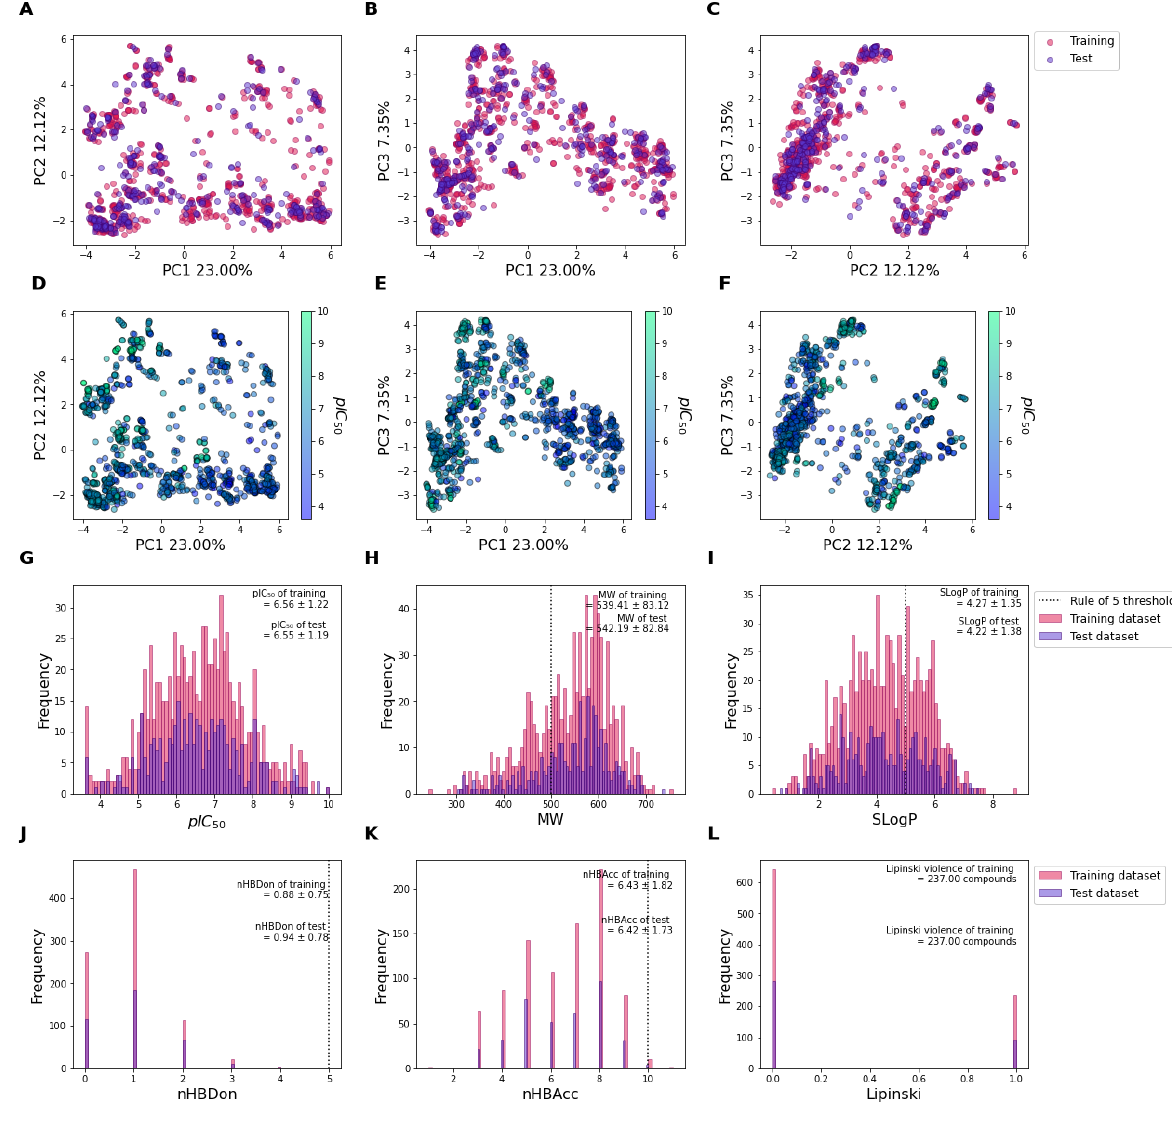
Figure 1. Principal component analysis (PCA) and chemical distribution of KRAS G12C datasets. Score plots of ( A ) PC1 and PC2; ( B ) PC1 and PC3; and ( C ) PC2 and PC3 were divided by training (pink circles) and test (purple circles) datasets. Numbers on the x and y axis indicate the percentage of explained variance for each PC. Score plots of ( D ) PC1 and PC2; ( E ) PC1 and PC3; and ( F ) PC2 and PC3 were labeled based on the pIC 50 values, where the light green and light purple indicate the high and low pIC 50 , respectively. Histograms of ( G ) pIC 50 ; ( H ) molecular weight (MW); ( I ) LogP (SLogP); ( J ) the number of H-bond donors (nHBDon); ( K ) the number of H-bond acceptors (nHAcc); and ( L ) the number of Lipinski’s rule violations were divided by training ( pink bars) and test (purple bars) datasets. The dashed line indicates the rule of five (Lipinski ’ s rule) threshold.